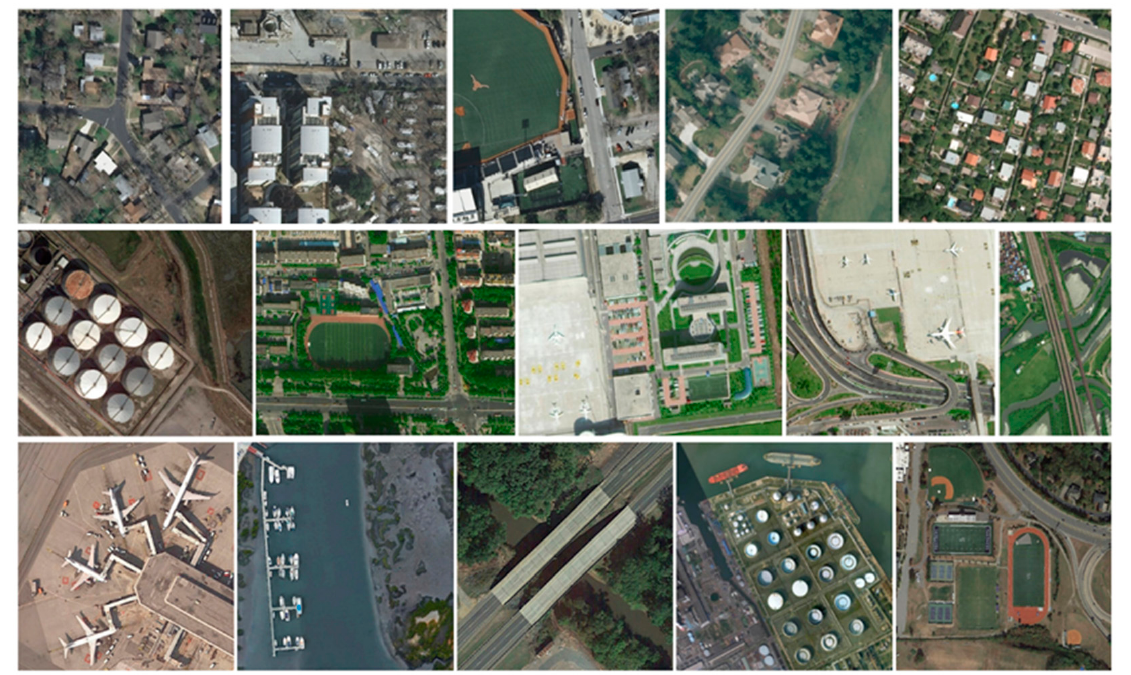
Figure 7. Sample images for three datasets. The first row’s dataset is AIBD, the second row’s dataset is HRRSD, and the third row’s dataset is DIOR.